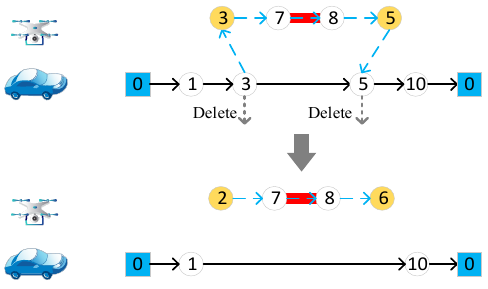
Figure 6. Change the start and end nodes of a drone route. Different numbers in the figure repre- sent different nodes of the road network.